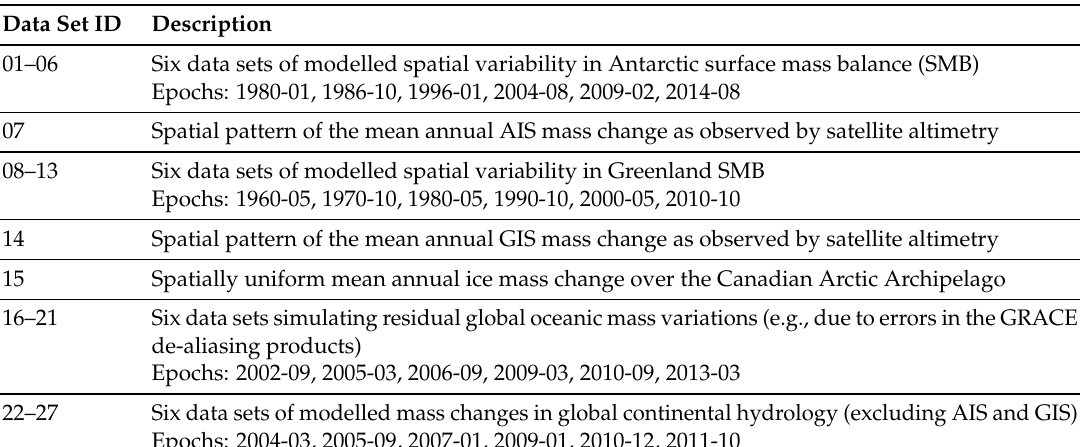
Table 1. Individual synthetic data sets utilised to quantify signal leakage. For data sets extracted from perennial model time series the selected epochs are